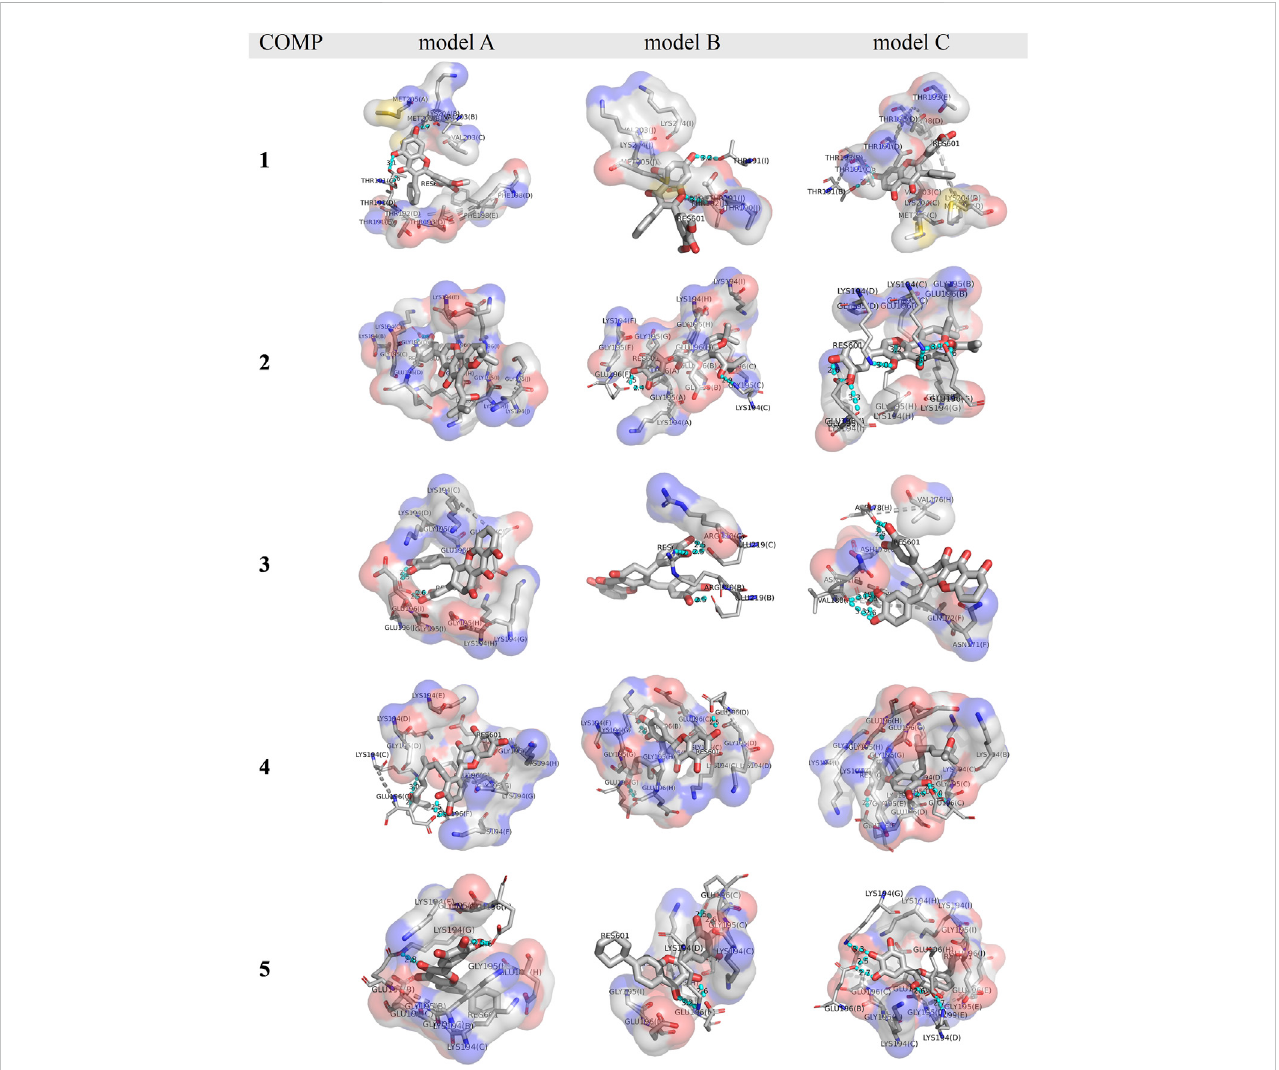
FIGURE 6 Aclose viewofthebindingcavities inCOMPs 1-5 withfPrP 170 – 229 .The hydrogenbondbetweenCOMPs andfPrP 170 – 229 isshown asacyandotted line.A gray dotted line connects the amino acid in the same strands of fPrP 170 – 229 that acts as a hydrogen bond donor or acceptor. RES601 is the COMP in each